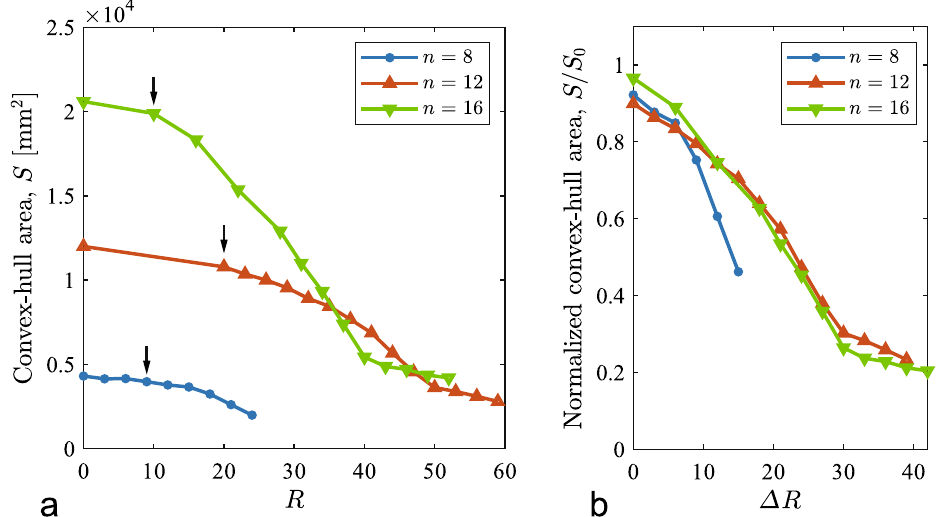
Figure 4. Changes in the convex-hull area during traction tests: ( a ) S vs. R , in which the downward arrows in ( a ) correspond to onsets of the conformation at R cr , with R cr = 9, 20 , and 10 for n = 8, 12 , and 16, respectively—critical points we identified through visual observation; ( b ) S / S 0 vs. (cid:31) R , where S 0 is the initial value of S and ∆ R = R − R cr